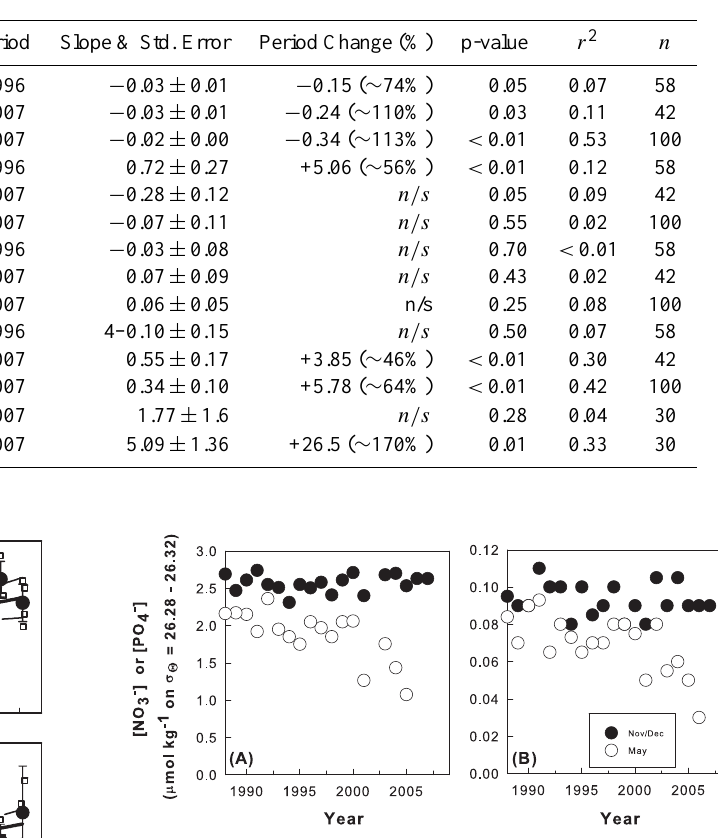
Fig. 2. Time-series plots of (a) [NO − centrations before (Nov/Dec, filled circles) and after (May, open circles) the winter/spring period on isopycnal band σ θ =26.28– 26.32kgm − 3 . Lines are drawn to the data to depict trends and are not statistical